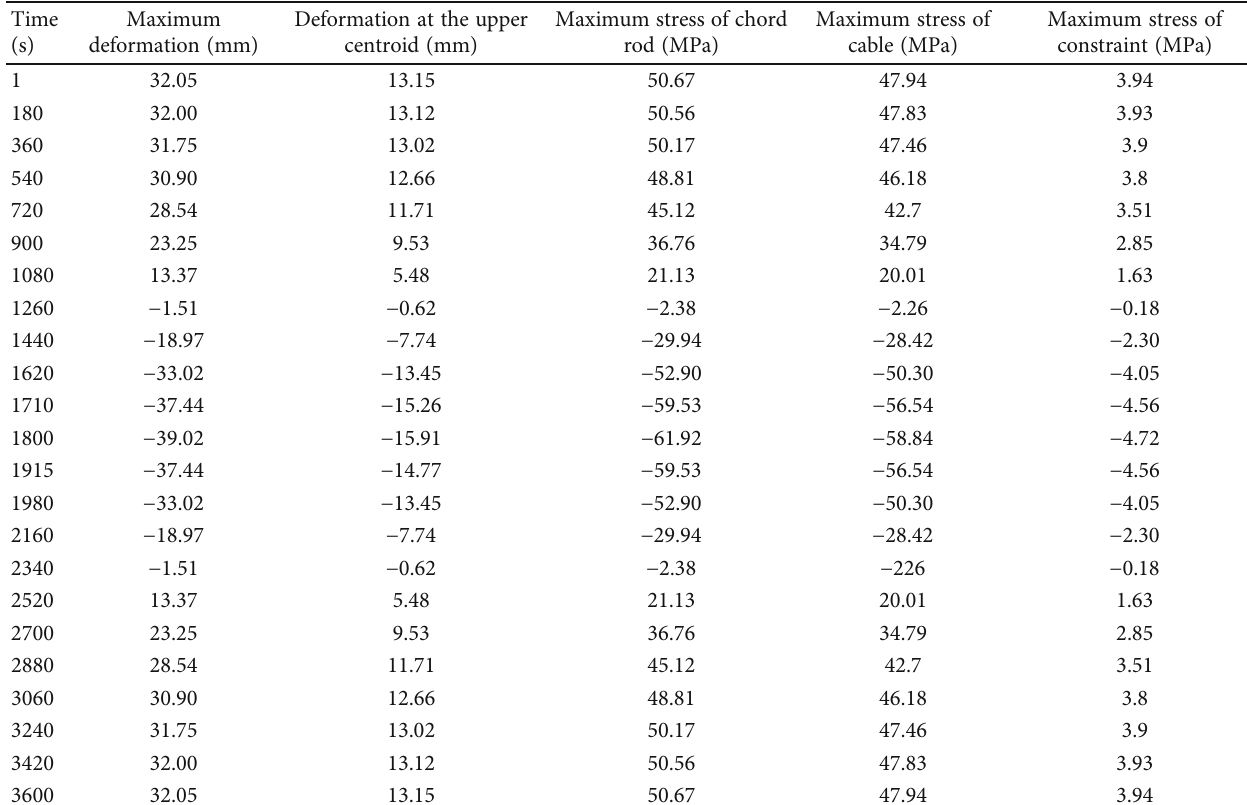
Table 2: Statistical analysis of thermal stress and